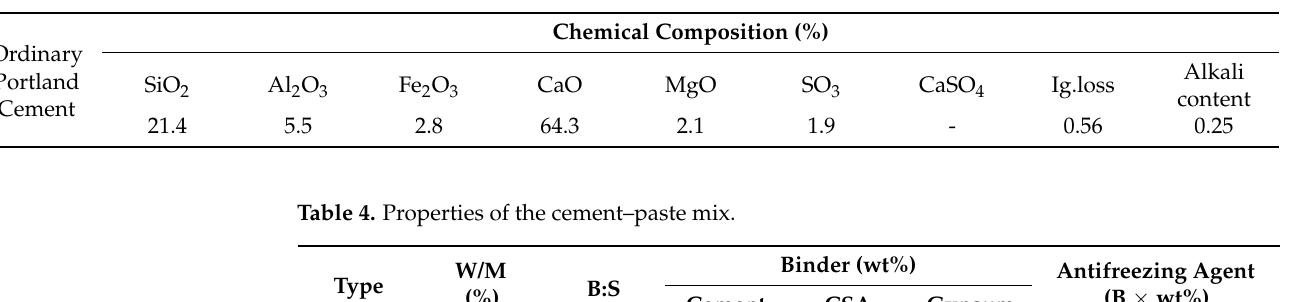
Table 3. Chemical composition of cement.